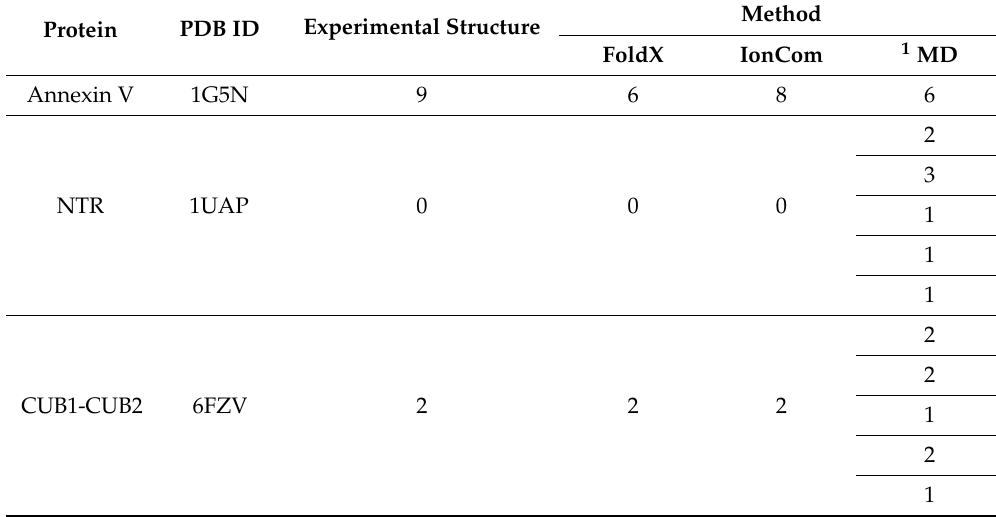
Table 6. Ca 2 + predictions for annexin V and PCPE-1 domains: number of the binding sites predicted are provided.